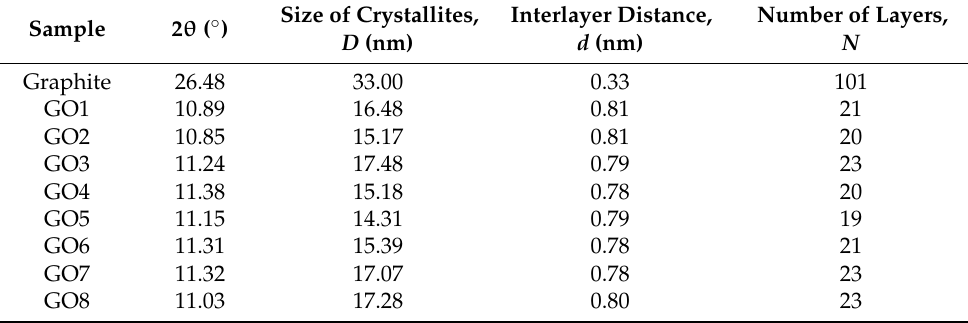
Table 3. Data obtained from X-ray examinations of the size of crystallites, the number of graphene layers in graphite and graphene oxides, as well as the distance between them. Size of Crystallites, Sample 2 θ ( ◦ )